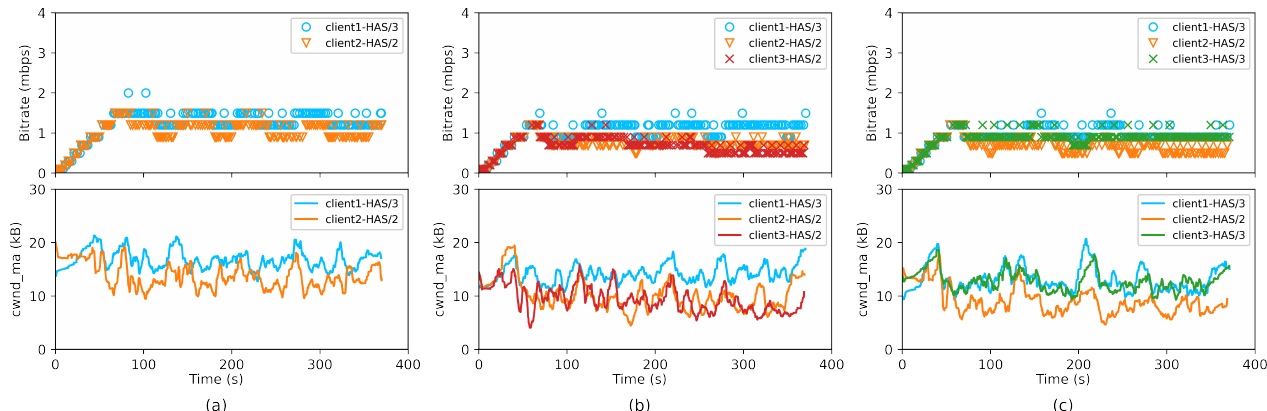
Figure 5. The representative time-varying bitrates and cwnd _ ma of the clients running the fairness ABR with B = 3 (mbps), under the scenario ( a ) S 11 , ( b ) S 12 and ( c ) S 21 .